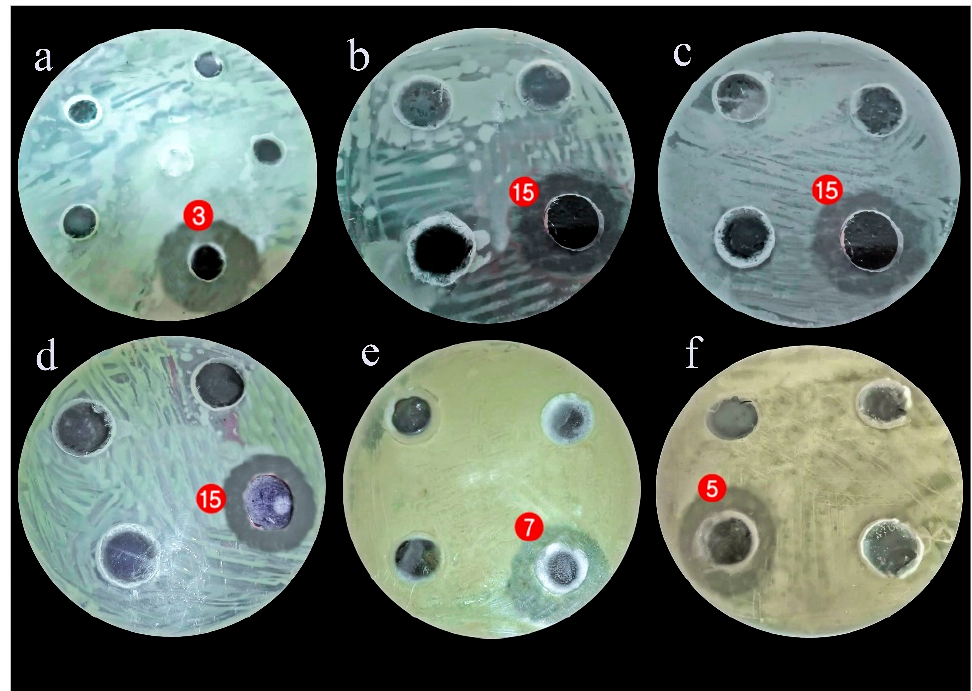
Figure 1. The inhibitory effect of ( a ) Stenotrophomonas maltophilia (3) against Streptococcus mutans, ( b ) Serratia marcescens (15) against Streptococcus mutans; ( c ) Serratia marcescens (15) against Enterobacter cloacae; ( d ) Serratia marcescens (15) against MRSA; ( e ) Bacillus cereus (7) against Candida albicans; ( f ) Delftia acidovorans (5) against Penicillium italicum.